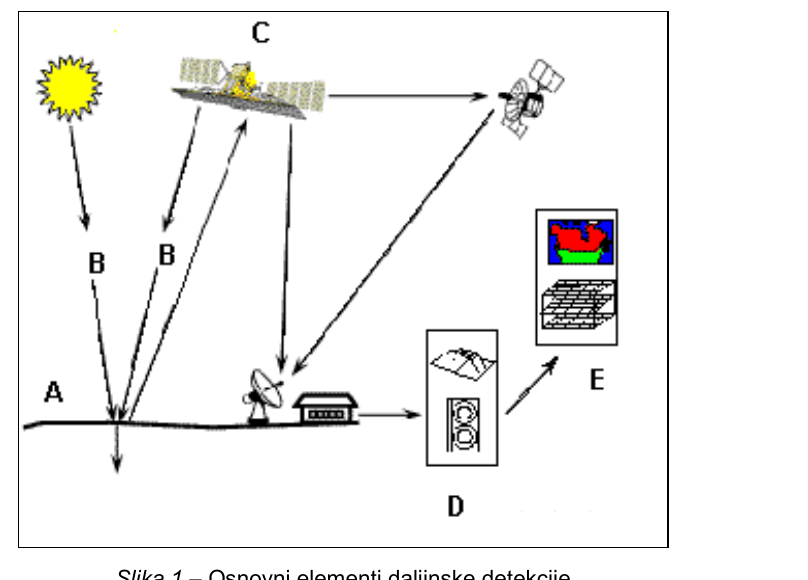
Figure 1 – Basic elements of remote